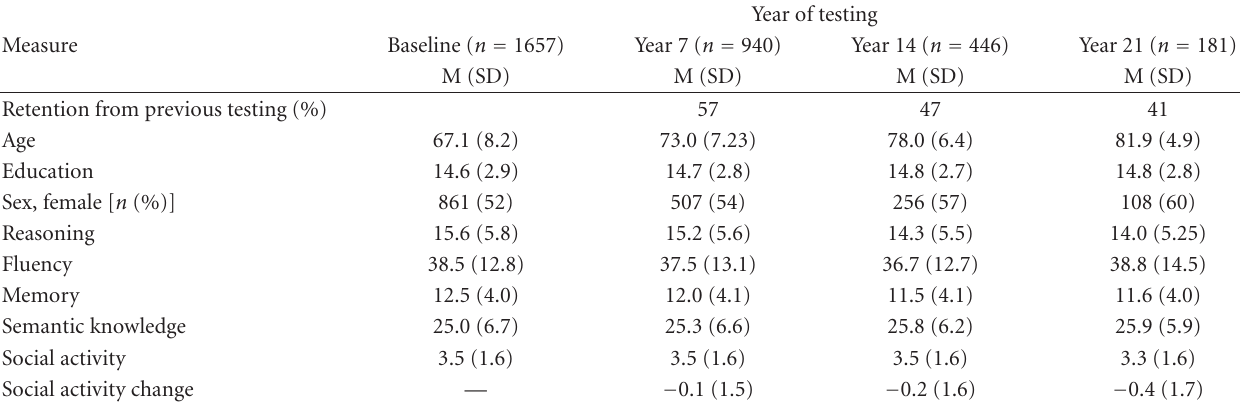
Table 3: SLS participant